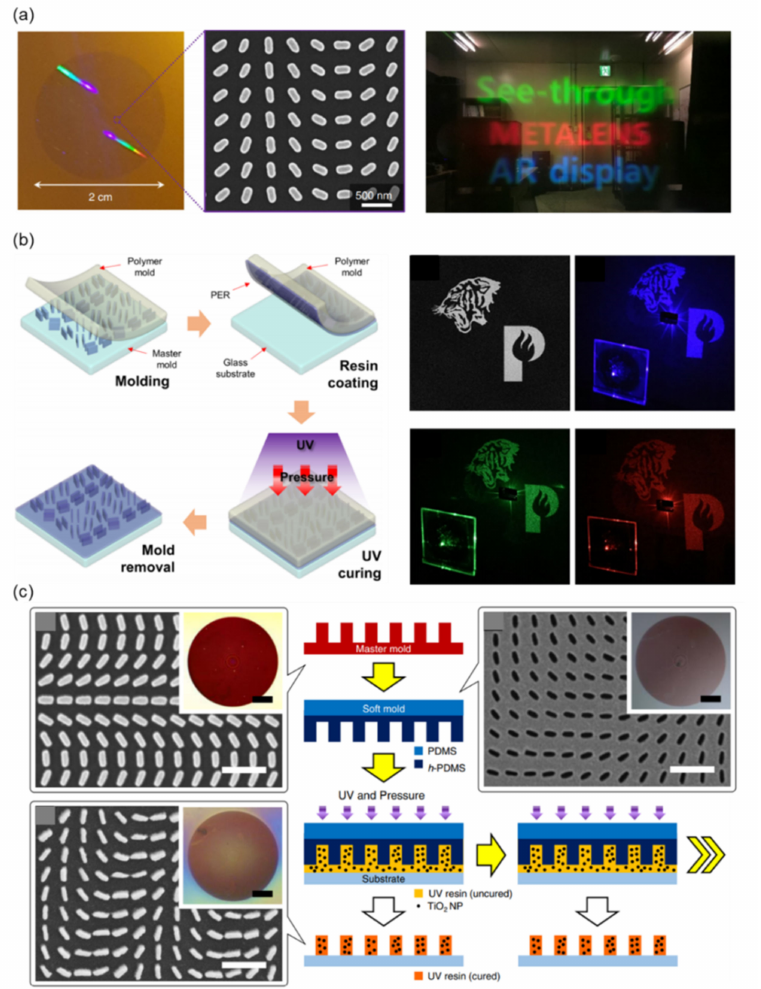
Figure 8. ( a ). Photograph of a see-through metalens with a diameter of 20mm (left); a SEM image of part of the PB-phase metalens (middle); AR images in red, green, and blue (right) [195]. ( b ) Schematic of the nanocasting process (left) and simulated holographic image and measured holographic image under incident lasers of λ = 450, 532, and 635 nm (right) [82]. ( c ) Schematic of the metalens fabrication process. SEM images and photographs (inset) are the master mold, soft mold, and final metalens. All scale bars of the SEM and photographs are 1 and 100 µ m, respectively